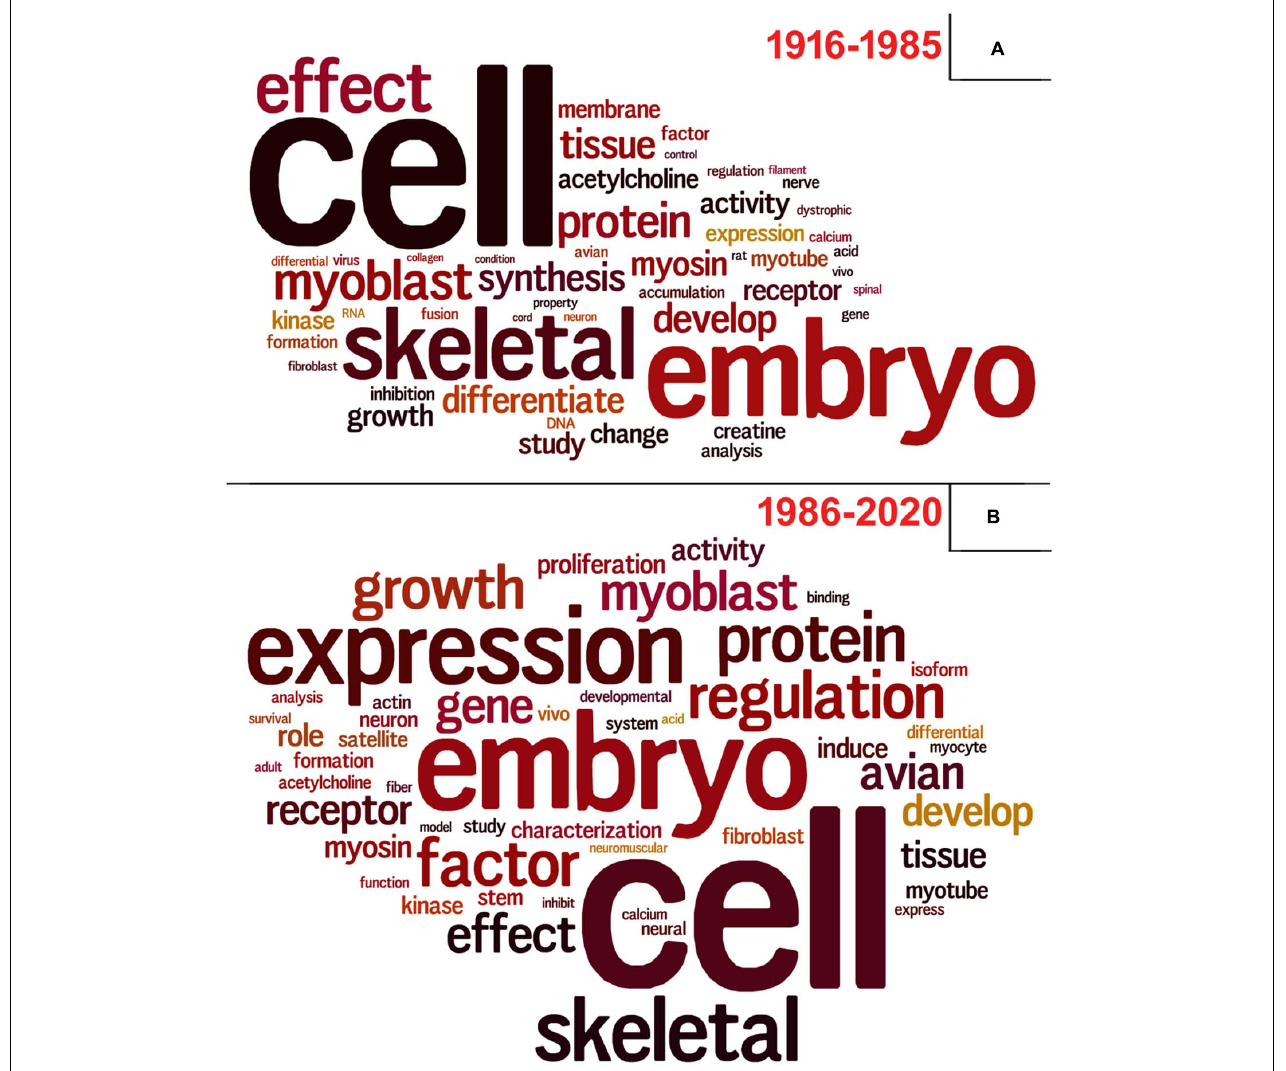
FIGURE 9 | Vocabulary analysis of the articles using chick muscle cultures. (A) A word cloud was generated using the titles of articles on primary culture of embryonic chick myogenic cells. This method gives greater prominence to frequent words. (B) Word frequency list. The retrieved PubMed dataset only included papers until the year of